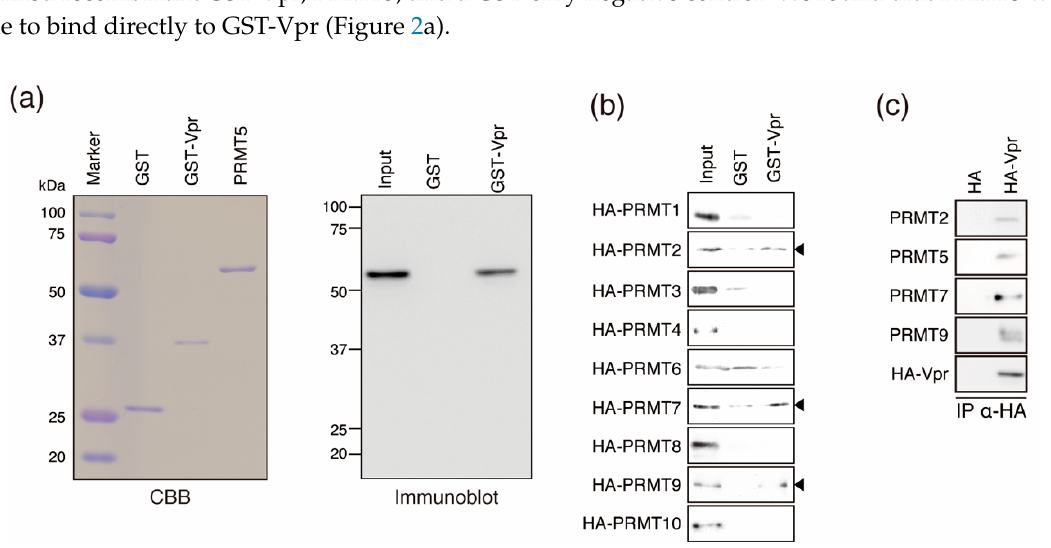
Figure 1. Identification of the Vpr-binding protein PRMT5. ( a ) Separation of Vpr-binding proteins by SDS-PAGE. The red arrow indicates the binding protein identified in this study. The blue arrows indicate FLAG-tagged-mRFP-FLAG-tagged-Vpr (mRFP-Vpr lane) and FLAG-tagged mRFP (mRFP lane). The black arrows indicate the heavy and light chains of the anti-FLAG IgG monoclonal antibody. ( b ) Peaks from MALDI-TOF MS analysis of the Vpr-binding protein after band excision and trypsin digestion. For peptide mass fingerprinting, the peak list was compared against the NCBI nr database using the MASCOT program. ( c ) The amino acid sequence of PRMT5 with matched peptide fragments identified by MALDI-TOF MS shown in red.